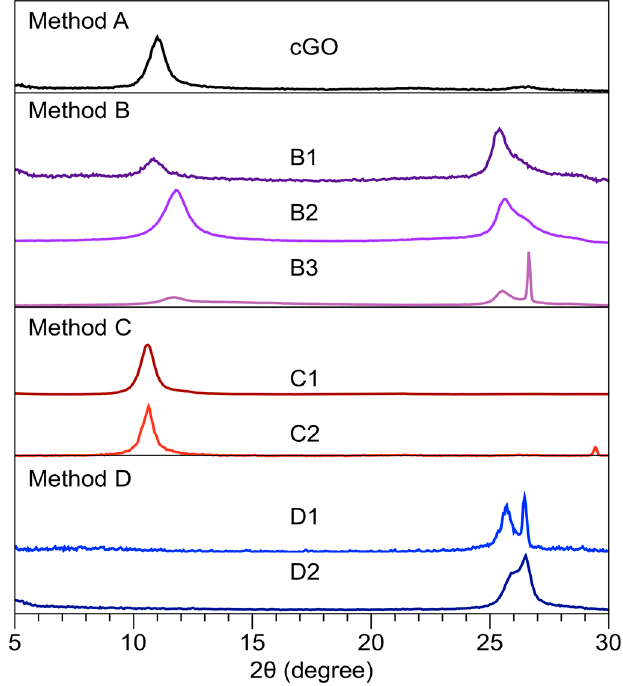
Figure 2. X-ray diffraction pattern of method A (cGO), method B (B1, B2, B3), method C (C1, C2), and method D (D1, D2).